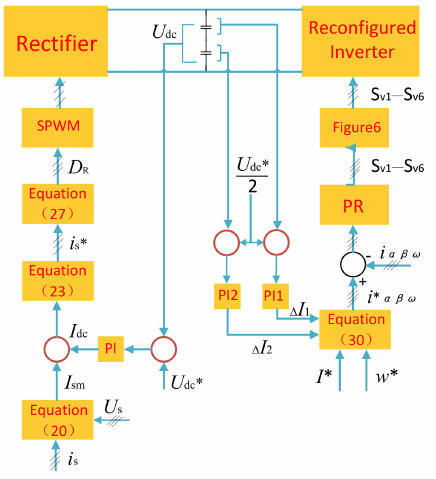
Figure 5. Overall control block